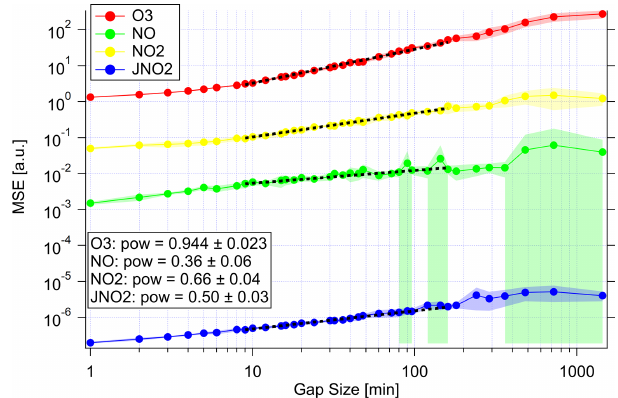
Figure 3. MSE of the SMC estimation as a function of artificial data gap size to study the interpolation capabilities. Mean MSE as lines and markers and standard deviation as shaded region for the ensem- ble of repetitions. The plot shows the results of all variables: ozone (red), NO (green), NO 2 (yellow) and j NO (blue). Note that the unit 2 of MSE is arbitrary to fit all variables in one plot. The unit is parts per billion by volume squared (ppbv 2 ) for the MSE of trace gases and inverse seconds squared (s − 2 ) for the MSE of the photolysis frequency. The dashed black lines show power-law fits ( y = Ax pow ) fitted to the intermediate regions. The fit estimate for pow is given in the